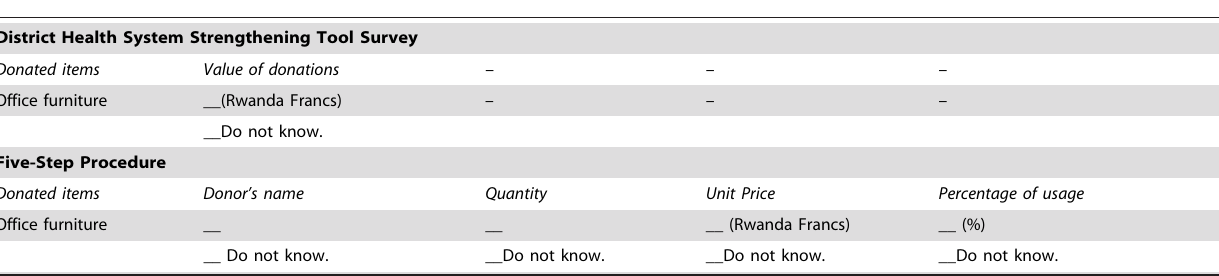
Table 1. Summary of different approaches in reporting in-kind support by the DHHST and the five-step procedure: an example.